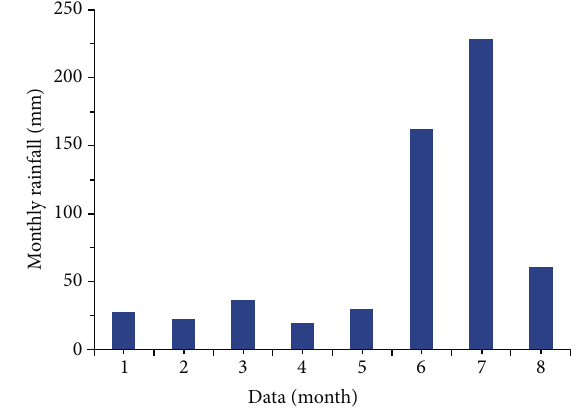
Figure 5: Monthly rainfall preceding the landslide event recorded by the Zhangjiawan Town rainfall station in 2017